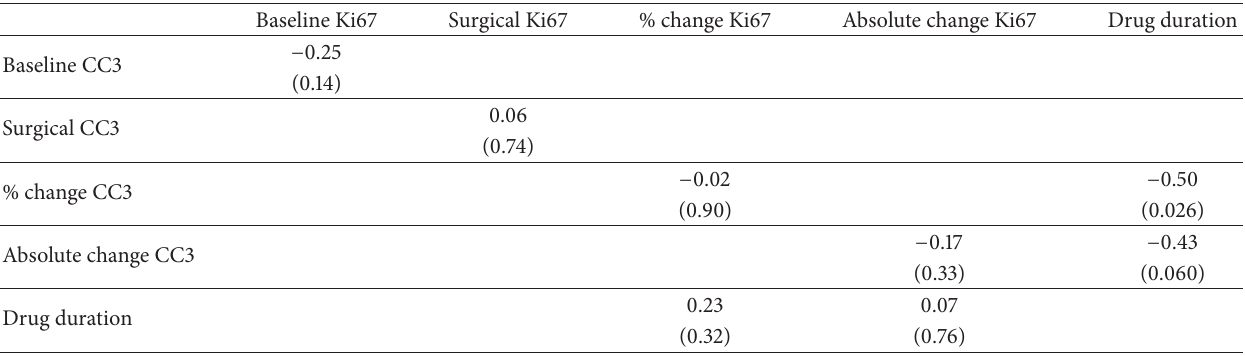
Table 3: Association between Ki67 labelling index and cleaved caspase 3 (CC3) values at baseline (before anastrozole) and surgery (after anastrozole) using the Spearman 𝑟 ( 𝑝 value) for